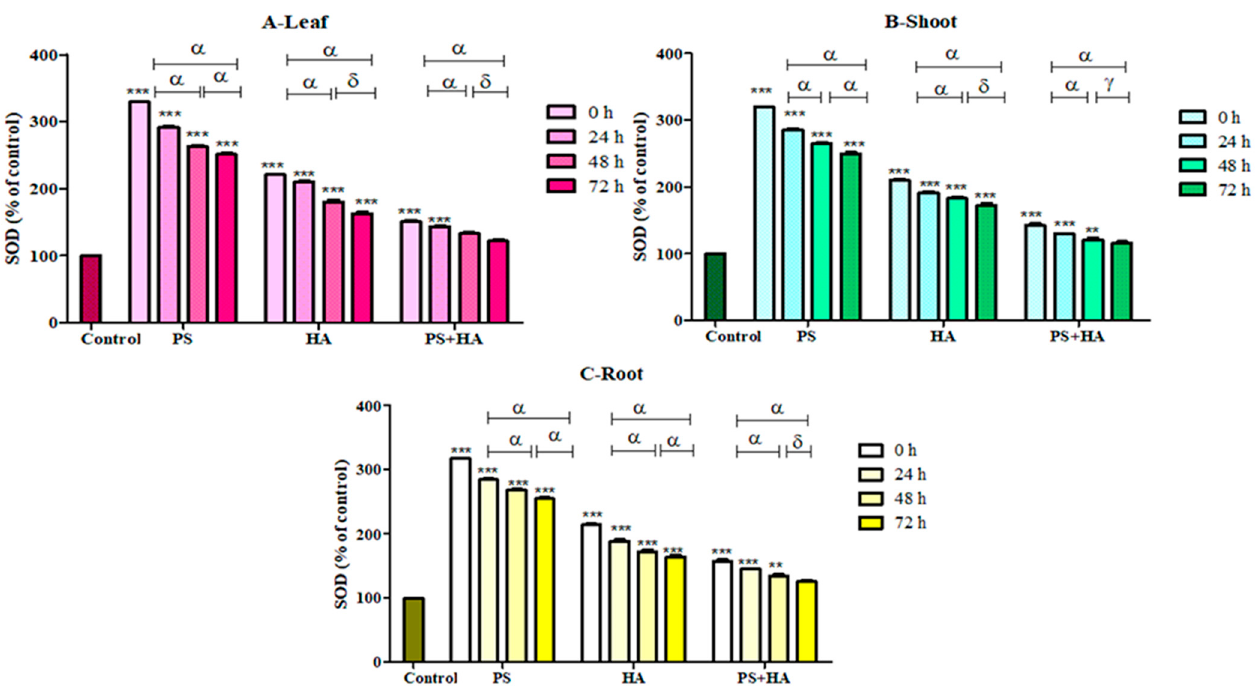
Figure 11. Percentage of Superoxide dismutase (SOD) values of PS, HA & PS + HA treated Solanum lycopersicum samples. Note: ‘ ** *** ’ indicates the percentage difference with respect to the control, ‘ α , δ , γ ’ indicates a significant difference ( α = p < 0.001, δ = p > 0.05, γ = p < 0.05).